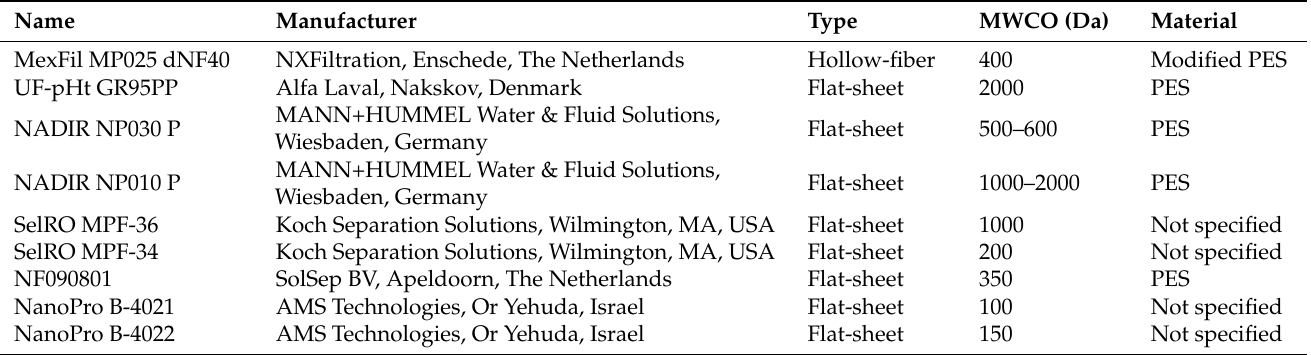
Table 2. Nanofiltration membranes tested and their characteristics. MWCO and material are shown as specified by the manufacturer in the data sheet of the